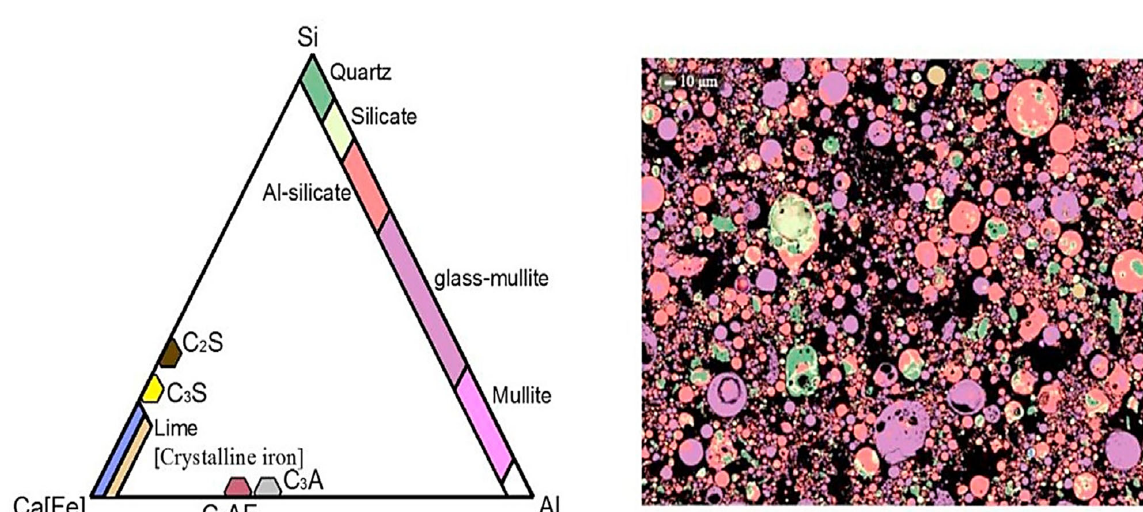
Figure 10. SEM ‐ EDS characterization of FA mineral phase composites based on intuition. Adapted from [79].